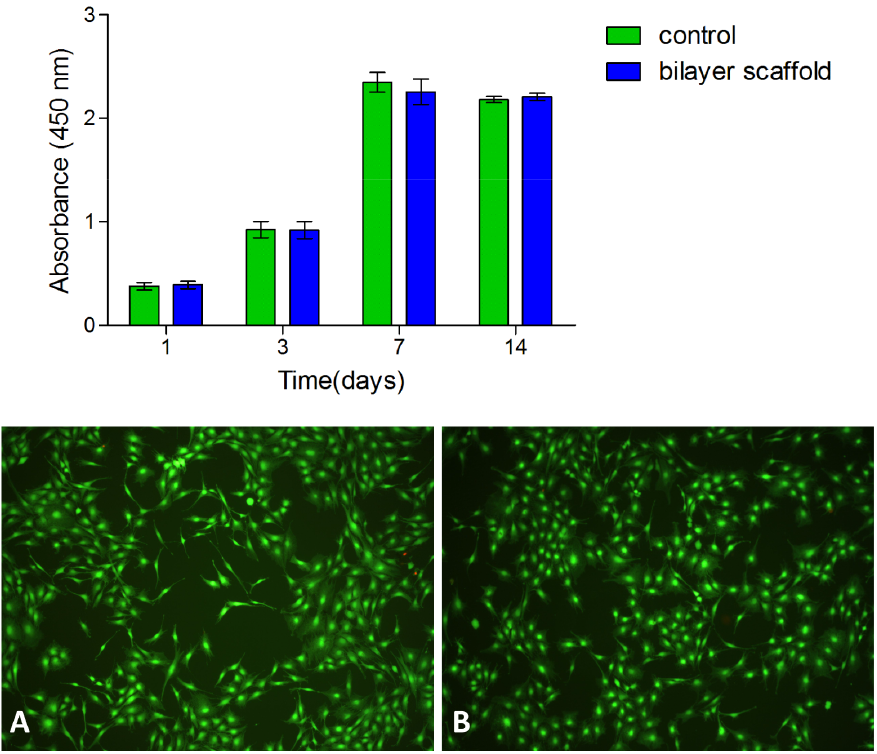
Figure 11. The proliferation of cells co-cultured with the bilayer scaffold in the CCK-8 assay. Cells were stained with Live/Dead staining solution (A: tissue culture plate; B: bilayer scaffold).